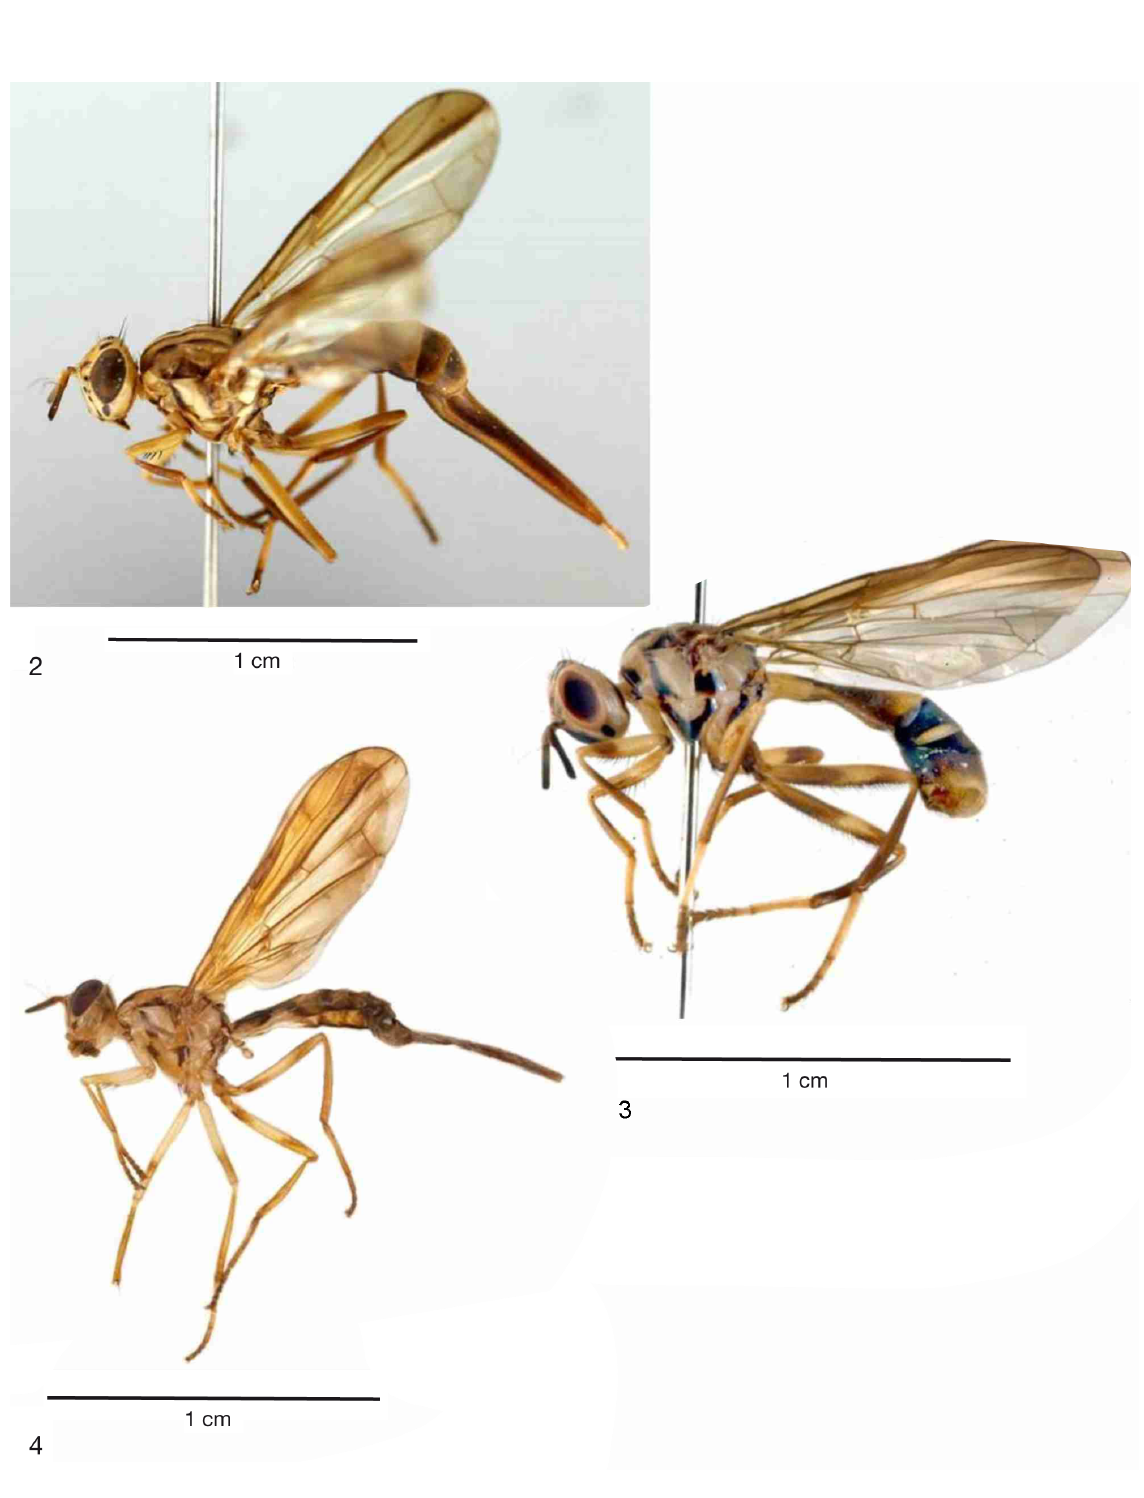
Figs 2–4. Ichneumonopsis spp., habitus. 2 . I. burmensis Hardy, 1973, ♀. 3 . I. hancocki sp. nov., holotype, ♂. 4 . I. taiwanensis sp. nov. , holotype,